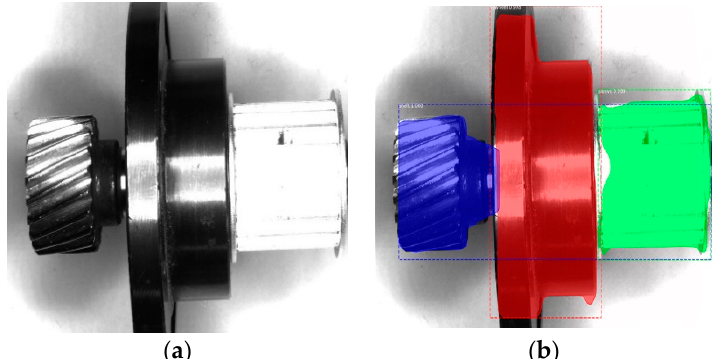
Figure 14. Multi-category test result.